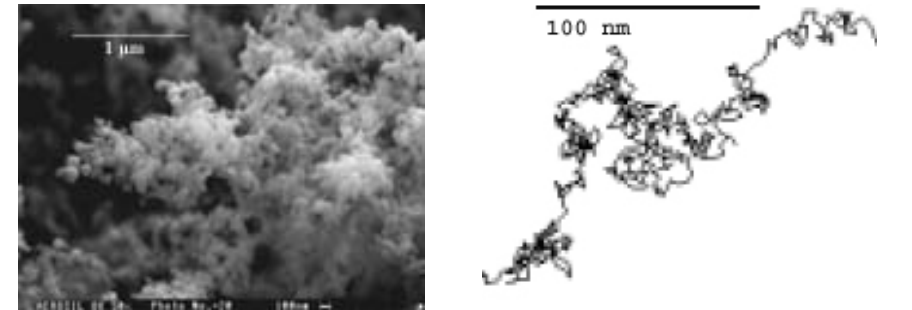
Figure 5. Snapshots of the aerosil OX 50 ( left ) [31] and of the linear polymer of molecular weight close to 1.5 × 10 6 Da ( right